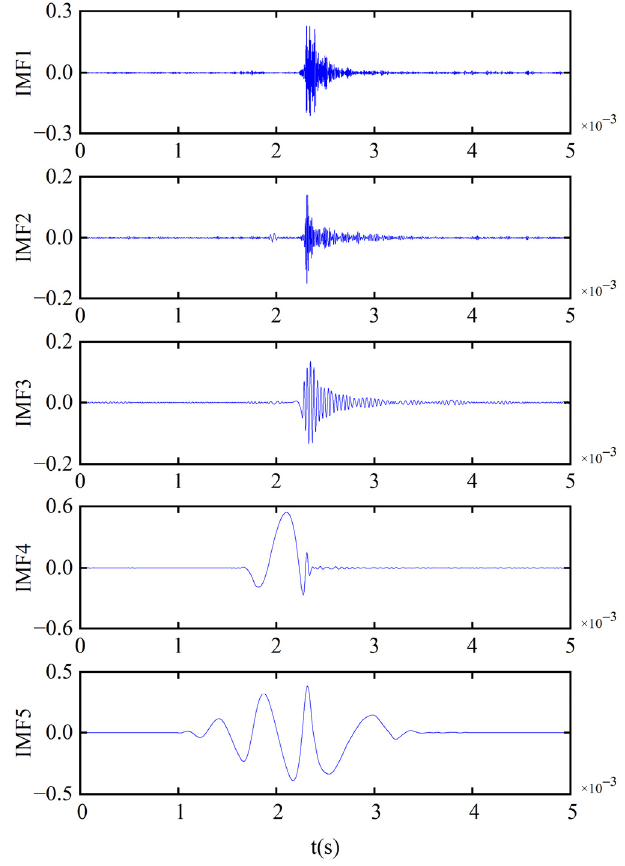
Figure 6. EMD decomposition results for the cylinder pressure.